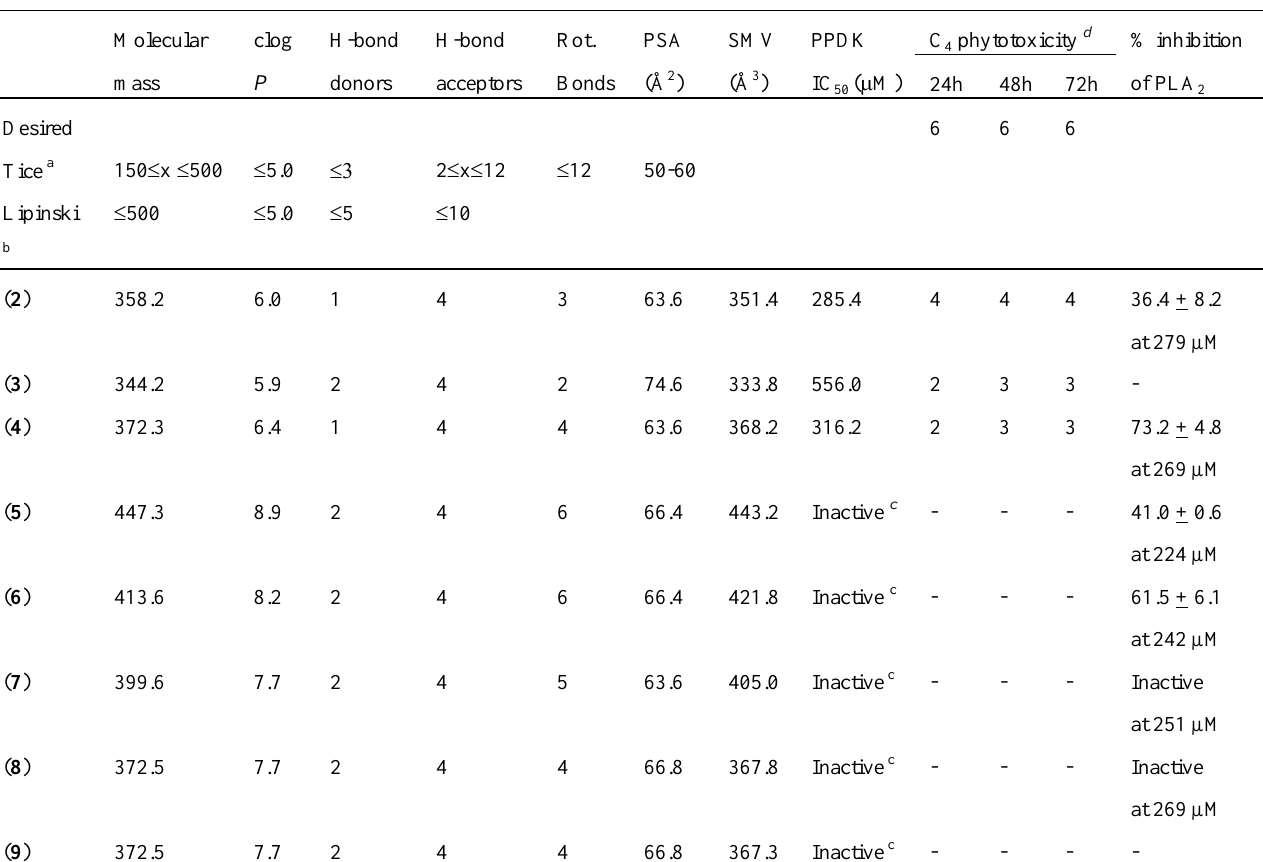
Table 2. Observed biological properties and calculated theoretical properties of the eight sesquiterpene hydroxyquinones/aminoquinones/hydroquinones 2 - 9 as compared to the desired range [28, 29,